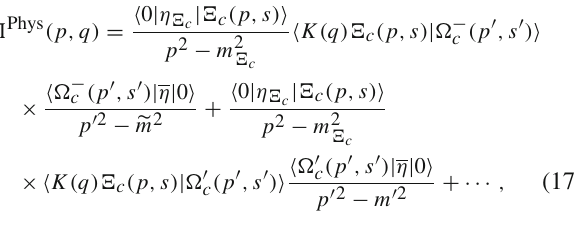
states (cid:2) (cid:4) − and (cid:2) (cid:4) (cid:4) constitute 15 and 9% of the whole c c